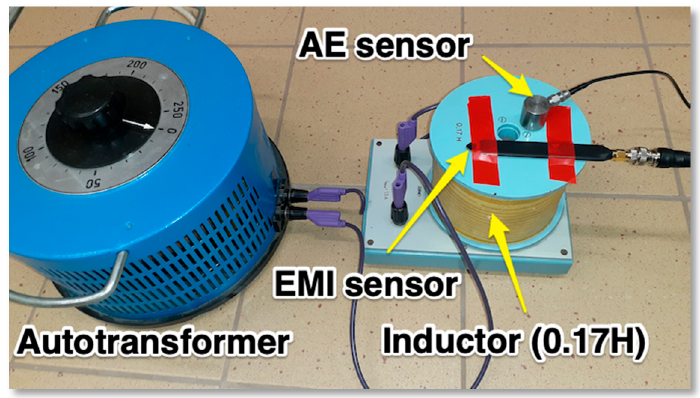
Figure 5. The sensors for AE and magnetic field signals detection. The sinusoidal voltage coming from autotransformer was applied to the coil and acoustic emission, magnetic field and current signals were recorded on the